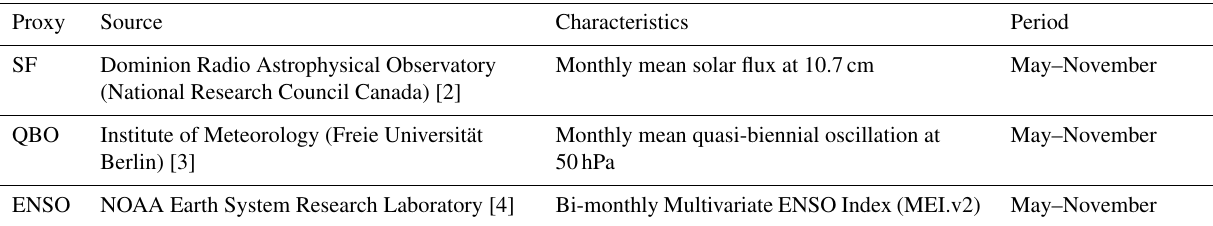
Table 1. Proxies: source, characteristics, and period. Proxy Source